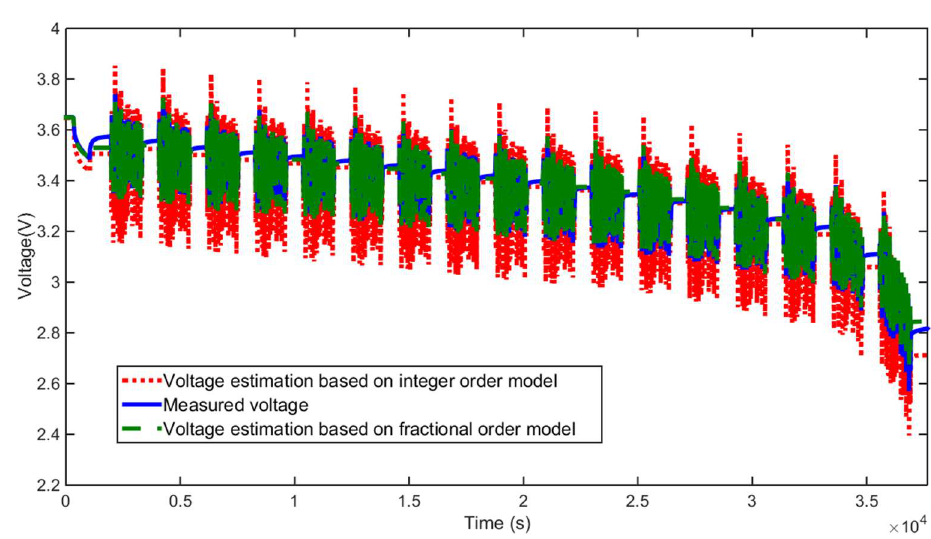
Figure 27. Comparison of voltage estimation based on fractional-order model and integer-order model.